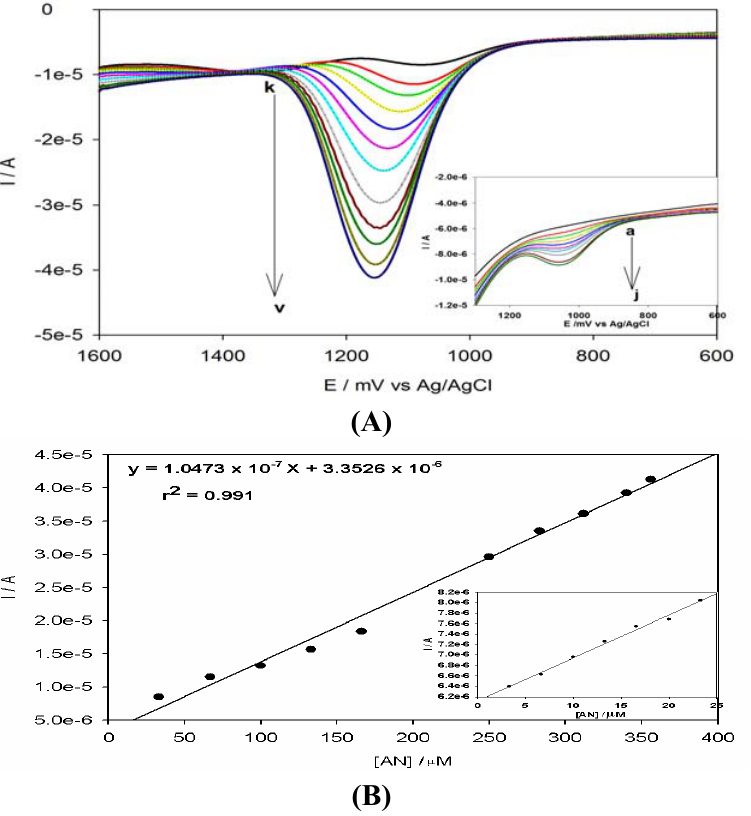
Figure 10. (A). Anodic difference SWV of PPyox/Ag-AuNPs/GCE in acetonitrile +0.1 M with different anthracene concentration: (a) 0, (b) 3, (c) 6, (d) 10, (e) 13, (f) 16, LiClO 4 (g) 20, (h) 23, (i) 26, (j) 28, (k) 33, (l) 66, (m) 100, (n) 133, (o) 166, (p) 200, (q) 233, (r) 250, (s) 283, (t) 312, (u) 340, (v) 356 µM .Inset shows the curves at low concentrations. (B). A calibration plot showing the relationship between current and concentration of anthracene. Inset shows a calibration plot at low